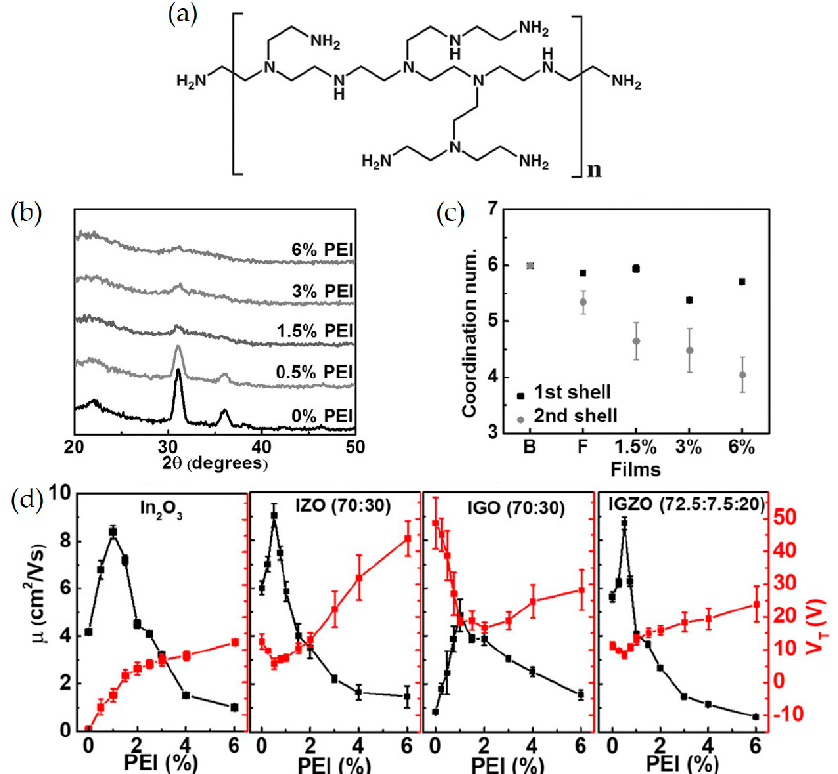
Figure 4. ( a ) Chemical structure of PEI. ( b ) GIXRD patterns of In 2 O 3 : x% PEI blend films with differing PEI concentrations. ( c ) Derived coordination number, In-O bond lengths for the indicated films. ( d ) TFT mobility and threshold voltage for In 2 O 3 : x wt % PEI (250 °C), IZO: x wt % PEI, IGO: x wt % PEI, and IGZO: x wt % PEI, as a function of the polymer concentration. T annealing = 300 °C. Reproduced with permission from [93], Copyright, 2016 Wiley-VCH Verlag GmbH & Co. KGaA, Weinheim.